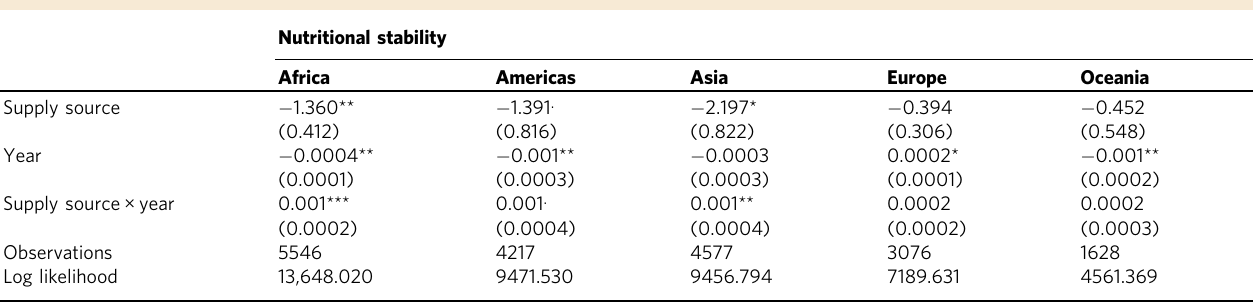
Table 1 Nutritional stability trends over time. Nutritional stability